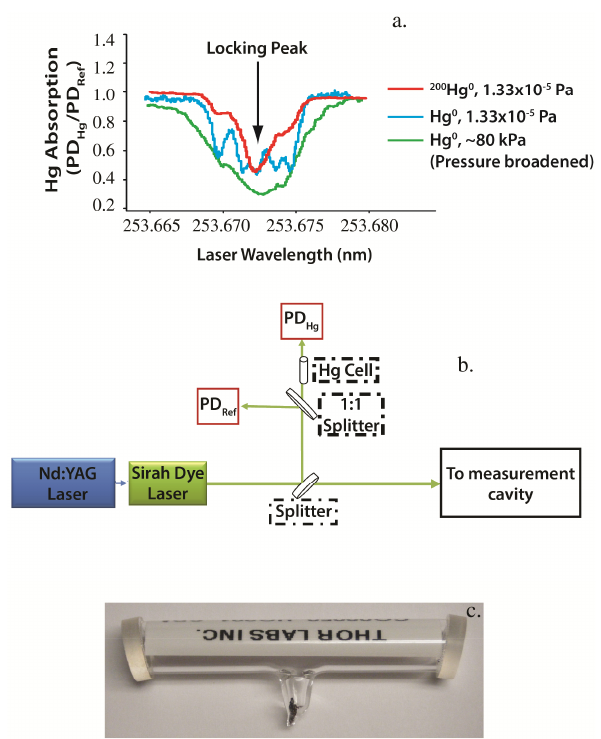
Fig. 1. (a) Absorption spectra of external Hg cells filled with metal- lic Hg ( ∼ 80kPa air and 1 . 33 × 10 − 5 PaHg pressure) and filled with isotopically enriched 200 Hg at 1 . 33 × 10 − 5 Pa pressure, plotted on a normalized y scale to compare different scans. Note that abso- lute wavelength numbers in figure are only approximations based on laser tuning grating position. (b) Schematic diagram of the ex- perimental setup including the Hg cell and position of two photodi- odes (PD) for control and locking of laser wavelength. (c) External quartz Hg cell filled with 200 Hg for wavelength locking of the laser